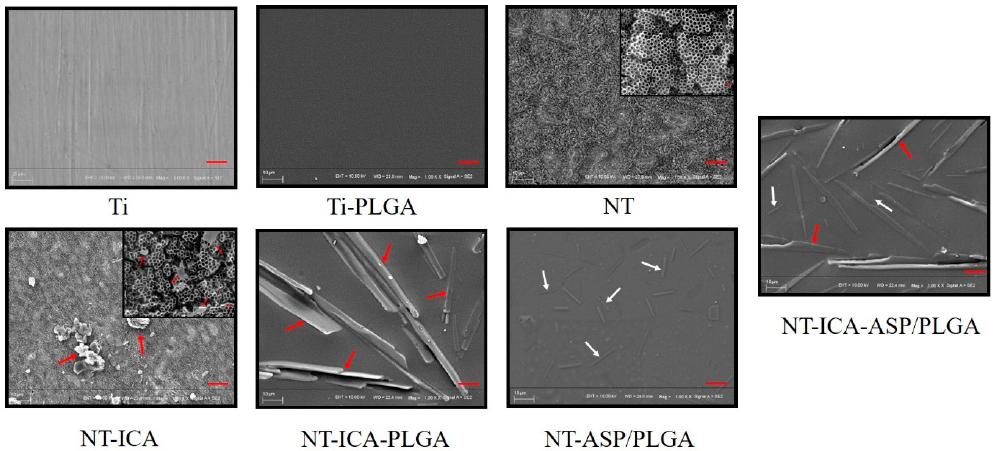
Figure 2. Surface micromorphology images of different substrates were obtained with scanning electron microscope (SEM, Zeiss Merlin Compact; ZEISS, Jena, Germany). Red and white arrows indicate icariin (ICA) and aspirin (ASP), respectively; 1000×, scale bar = 10 μ m. Insets of images of NT and NT-ICA substrates were magnified SEM graphs (30,000×, scale bar = 200 nm).